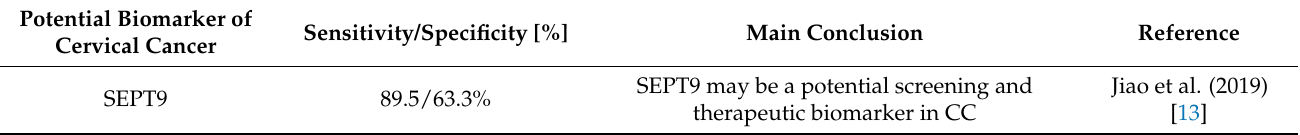
Table 1. Selected potential biomarkers of cervical